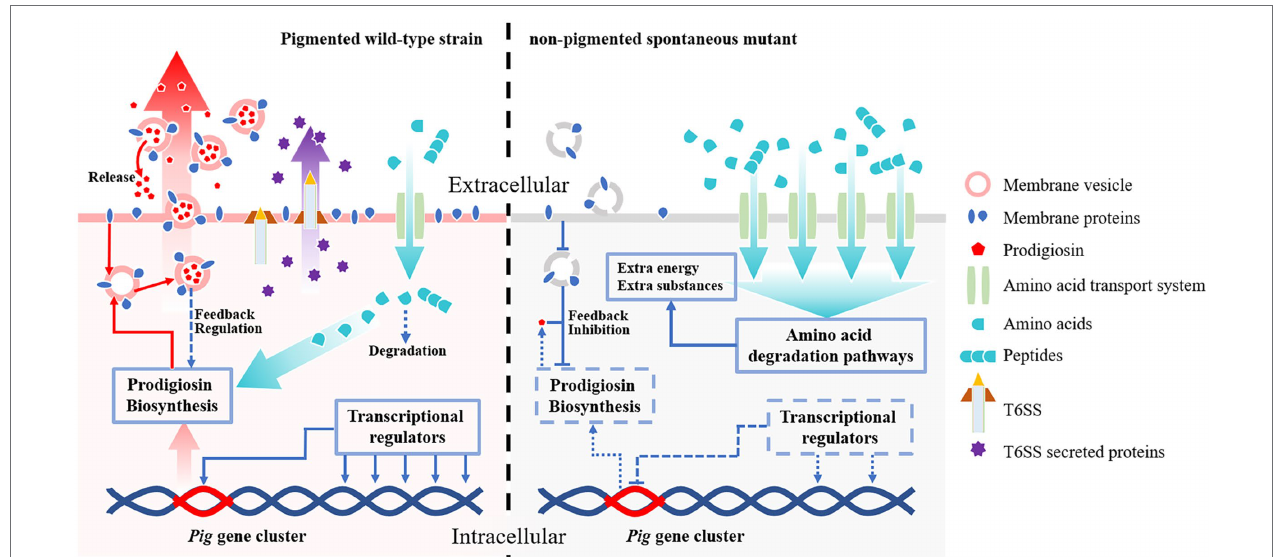
FIGURE 7 | The potential mechanisms contribute to competitive growth advantage in S. marcescens spontaneous mutants under laboratory conditions. Both the wild-type strain and its spontaneous mutants preserve the complete prodigiosin synthesis gene cluster ( Pig gene cluster). In the pigmented wild-type strain (left side), the pig genes are highly expressed under the control of transcriptional regulators, and the pigment is massively produced. The abundant prodigiosin is stored in membrane vesicles and secreted outside the cell by vesicular transport pathways to maintain lower intracellular concentrations which avoid feedback inhibition. The wild-type strain also consumes necessary resources to maintain some high-cost systems, e.g., T6SS. The amino acids required for prodigiosin synthesis and other systems are imported via amino acid transport systems, in which only a small amount of amino acids is degraded. In the non-pigmented spontaneous mutant (right side), the expression of the pig genes is highly suppressed by several factors. The transcriptional regulators, e.g., the positive regulator slyA , are down- expressed, which results in downregulated pig genes. Lack of essential membrane proteins for vesicle formation also potentially contribute to prodigiosin dyssynthesis. In this scenario, prodigiosin is neither correctly stored nor secreted outside the cells, which leads to strong feedback inhibition effects. Besides the pigment synthesis system, the non-pigmented mutant also shuts down T6SS or other high-cost systems to save resources. In addition, both amino acid transport- and degradation-pathways associated proteins are over-expressed in the non-pigmented mutant, which supplies extra nutrients and energies for bacterial growth. Therefore, the non-pigmented mutant shows a competitive growth advantage over the wild-type strain, which rapidly replaces the latter in laboratory